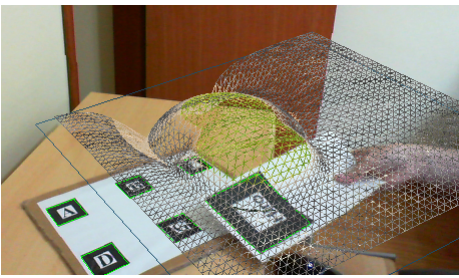
Fig. 18. A navigation moment